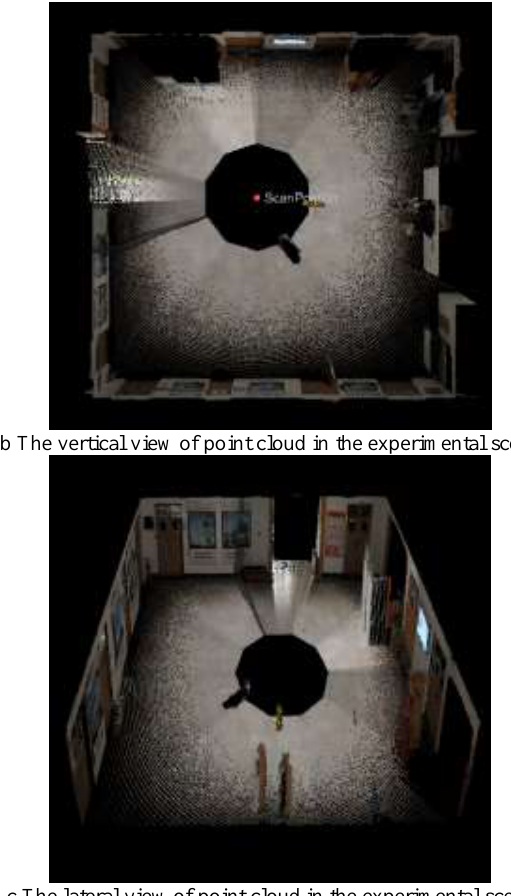
Figure 3.The laser-point cloud data in the experimental scene This paper uses Kinect to obtain the data of the experimental scene and 334 key frames of sequence images is obtained. The color image and the depth image of those key frames of data are shown as follows: